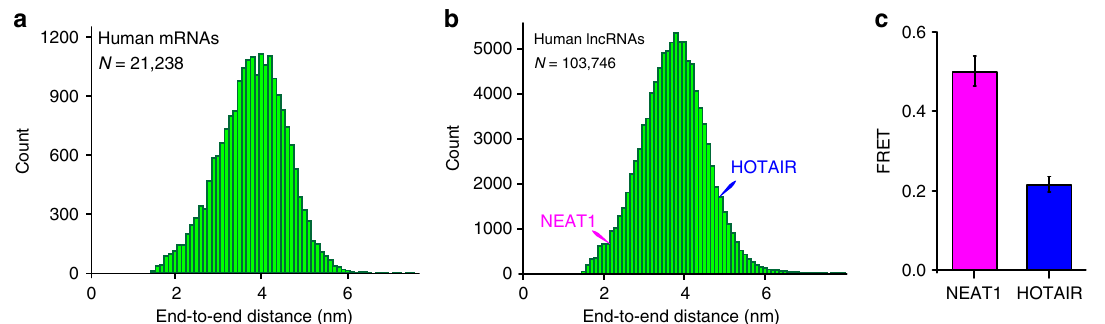
Fig. 3 The ends of human mRNAs and lncRNAs are universally close. a , b Distribution of computationally predicted average end-to-end distances in a mRNA sequences from the HeLa cell transcriptome and b human lncRNA sequences. N is the number of sequences analyzed. Predicted end-to-end distances in NEAT1_S and HOTAIR lncRNAs are indicated by blue and pink arrows. c Ensemble FRET values measured in NEAT1_S and HOTAIR lncRNAs. Each FRET value represents the mean ± SD of three independent